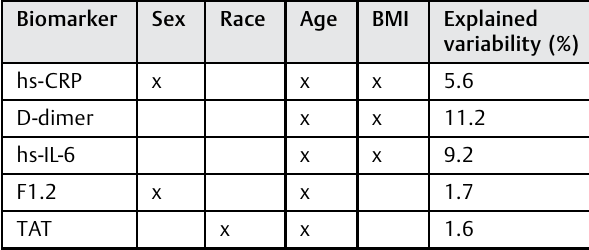
Table 1 Proportion of variability in biomarker baseline levels explained by demographic variables a Biomarker